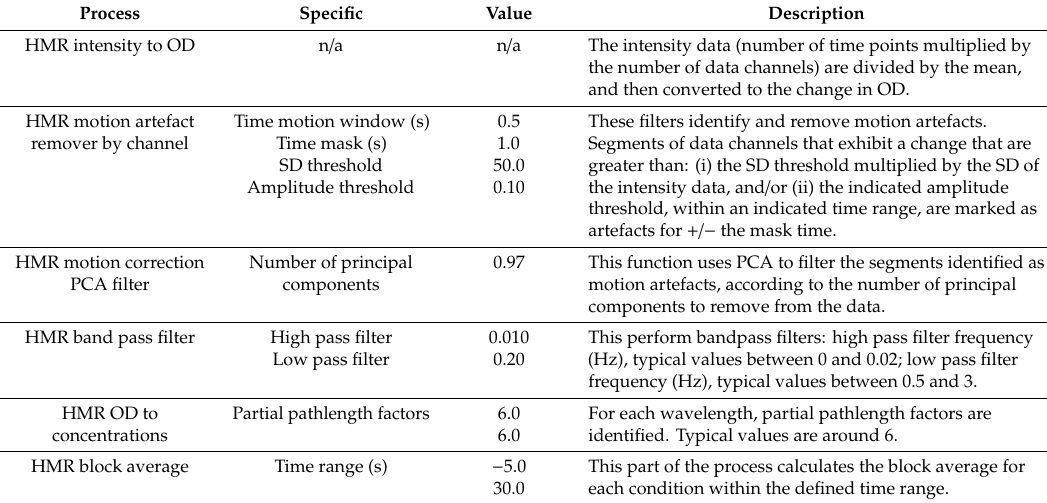
Table A1. Brain activity data processing pipeline values and description.